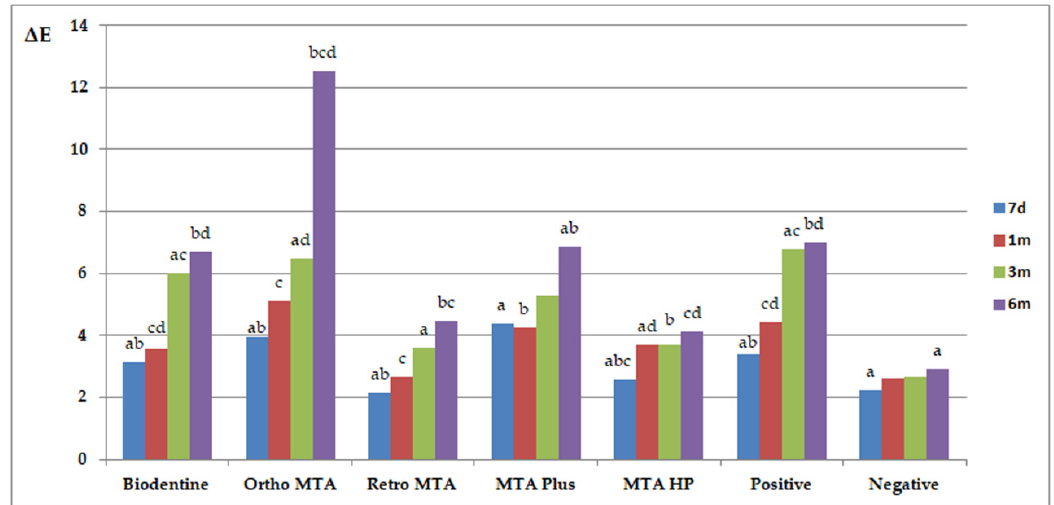
Figure 3. Mean Δ E values of tooth discolouration for different durations Similar letters indicate statistically significant differences between different time points within a material group ( p < 0.05); Biodentine (a 0.0041; b 0.0065; c 0.0191; d 0.0191); Ortho MTA (a 0.0284; b 0.0015; c 0.0052; d 0.0284); Retro MTA (a 0.0413; b 0.0073; c 0.0493); MTAPlus (a 0.0343; b 0.0065); positive (a 0.0032; b 0.0012; c 0.0494; d 0.0102); negative (a 0.0126).